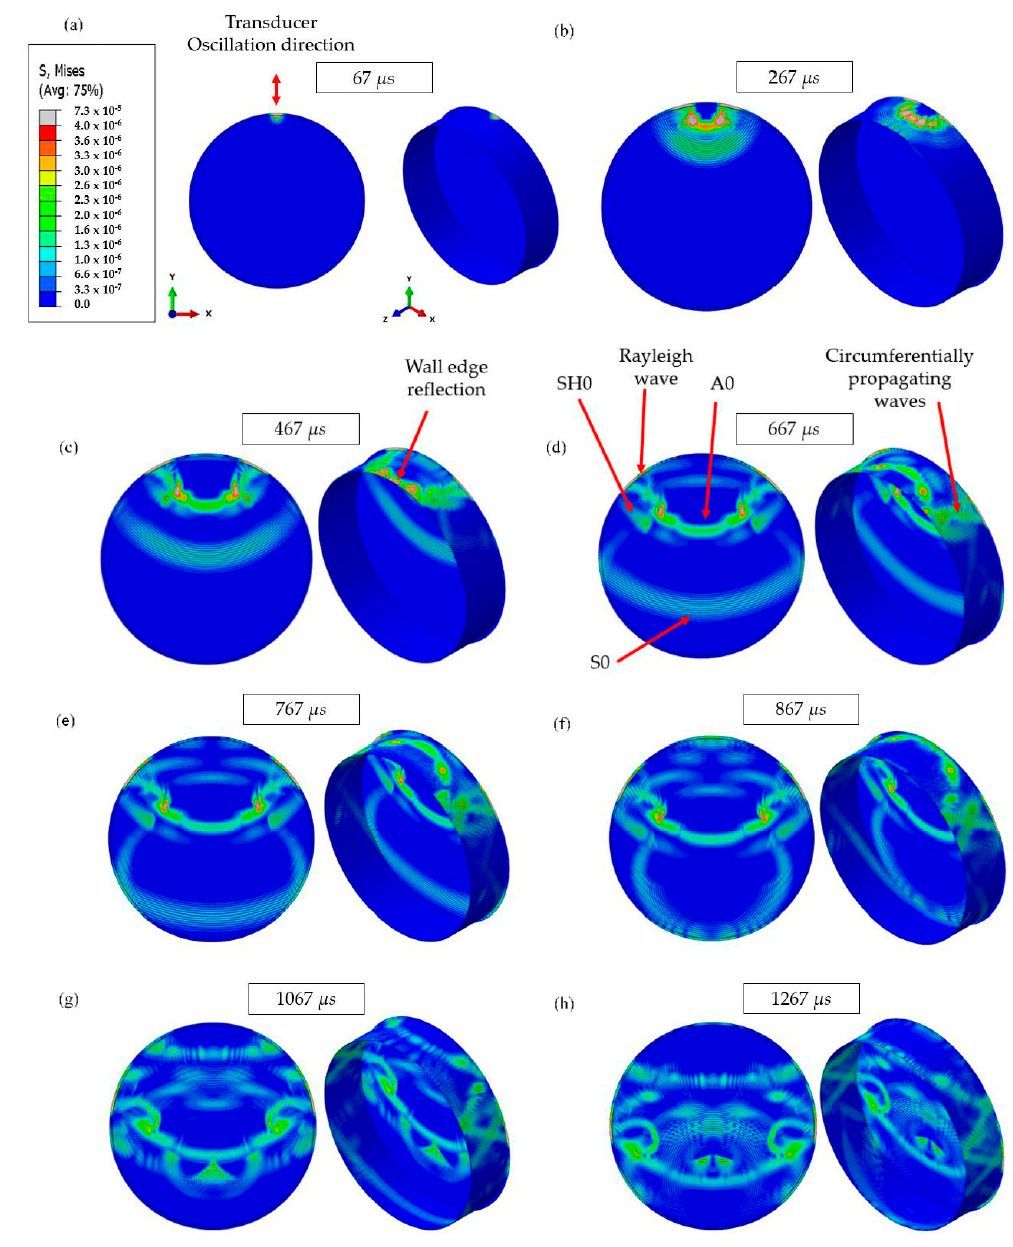
Figure 4. FEA results: wave propagation at different time increments on a steel 4.1 m diameter, 1 m wall tank at 60 kHz (the tank annular chime is used as the point-of-excitation as illustrated in Figure 3—case 1), and the color scale represents the Von-Mises stress. ( a ) 67 µ s, ( b ) 267 µ s, ( c ) 467 µ s, ( d ) 667 µ